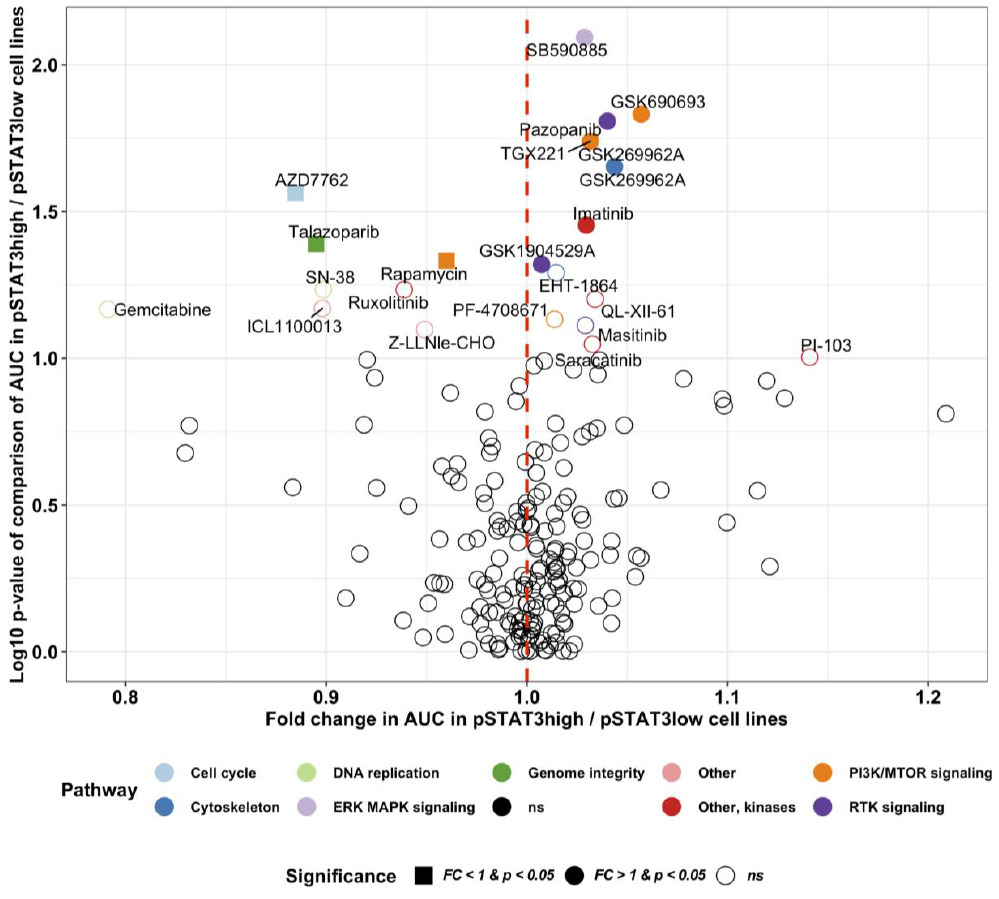
Figure 7. Di ff erential drug sensitivity in pSTAT3 high ( n = 27) and low ( n = 583) cancer cell lines. The pSTAT3 phosphorylation level has been quantified with reverse phase protein array (RPPA, cut-o ff pSTAT3 Tyr705 = 1). The drug sensitivity data represent the area under the curve (AUC) response of 265 di ff erent phamacological compounds, and has been retrieved from the Sanger GDSC dataset. The RPPA data are derived from the Broad Institute the Cancer Cell Line Encyclopedia (CCLE)